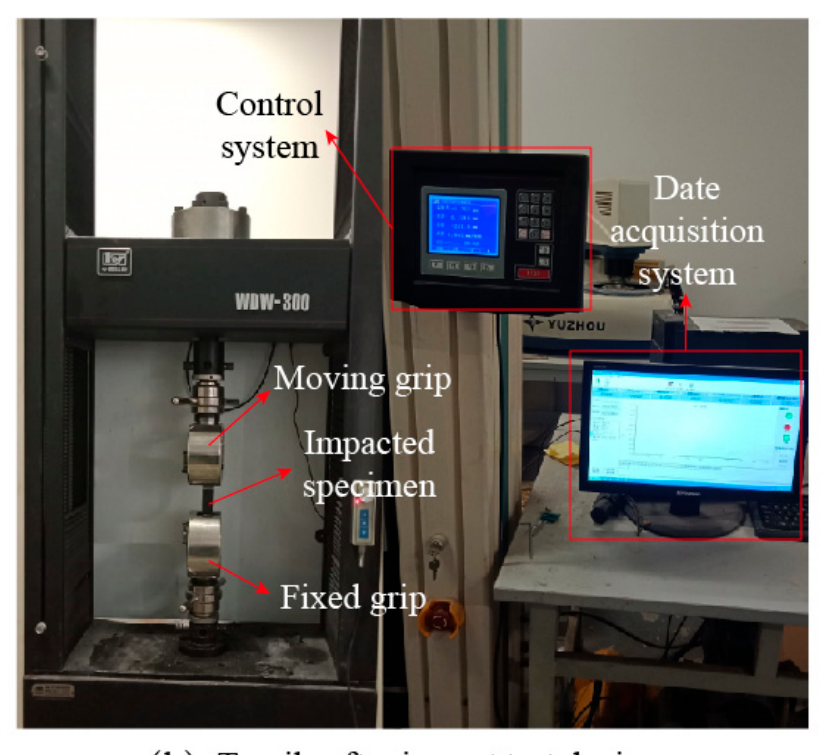
Figure 2. ( a ) Low ‐ velocity impact test device and ( b ) tensile ‐ after impact test devices. Figure 2. ( a ) Low-velocity impact test device and ( b ) tensile-after impact test To investigate the effect of different impact energies on the residual strength of the SLJs adhesively bonded structure. The uniaxial tensile test was designed according to the ASTM D1002 test standard [36], Experiments were carried out using WDW ‐ 300 (Changchun Kexin Testing Instruments Co, Changchun, China) universal tensile test machine. The relative error of test force is less than 1%. The clamped ends of the speci ‐ men were fixed by the knurling of the tensioner jig to prevent slippage. The lower end of the specimens was solidly supported and the upper end was moved with the beam by